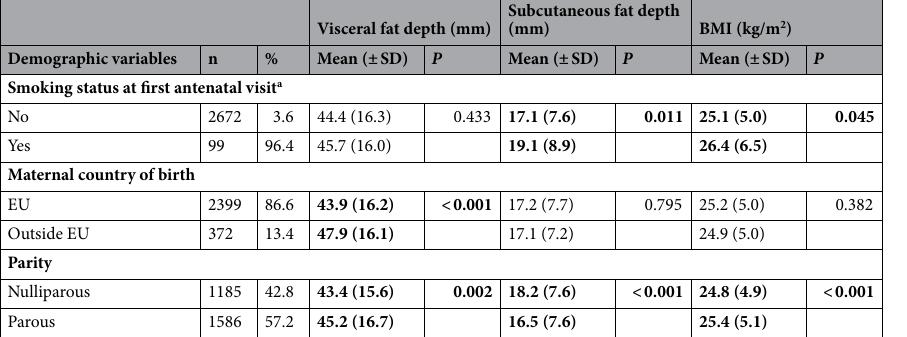
(Supplementary Table 1). Data on umbilical artery pH were available on 2118 infants, and out of these, 19 infants (0.9%) had umbilical artery pH ≤ 7.0 (Supplementary Table 1). Ninety-nine of 2771 infants (3.6%) were admitted to NICU (Supplementary Table 1).